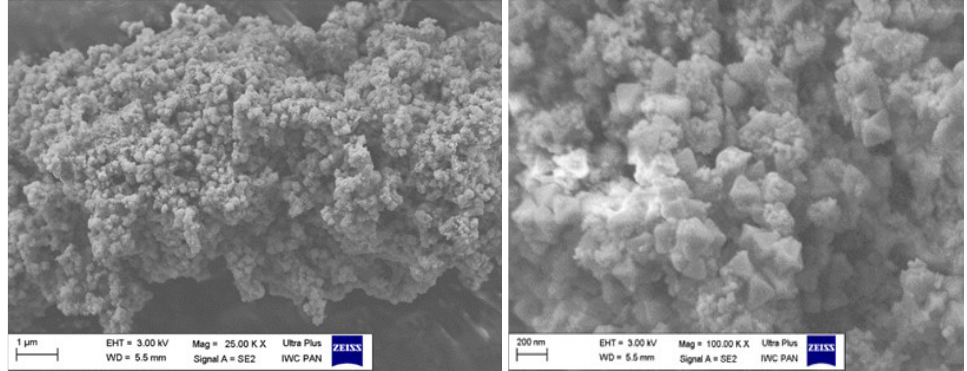
Figure 12. SEM images of the UiO-66_MAA sorbent after filtration at the sorbent-assisted microfiltration installation.